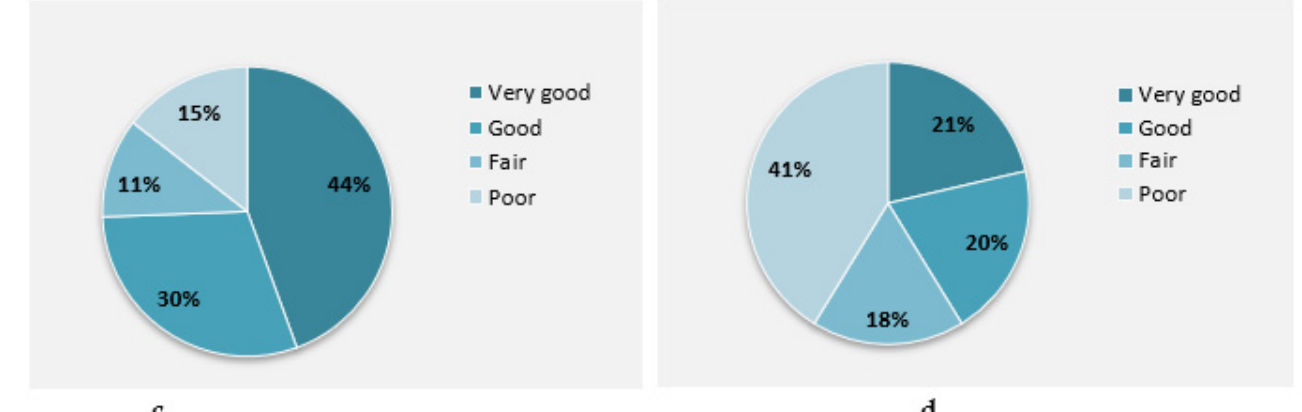
Figure 4. Field survey results of longitudinal drainage inlet conditions for overall inlet conditions ( a ), curb inlets ( b ), combined inlets ( c ) and grate inlets ( d ).